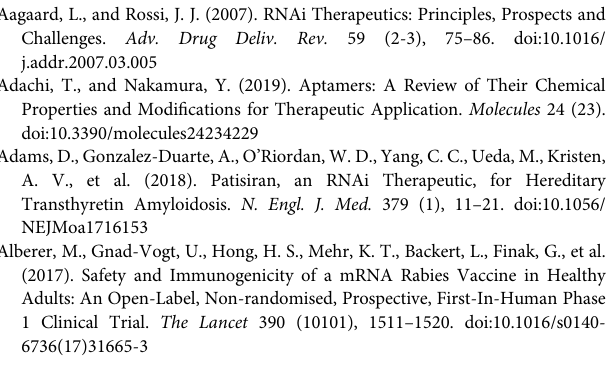
Frontiers in Molecular Biosciences |